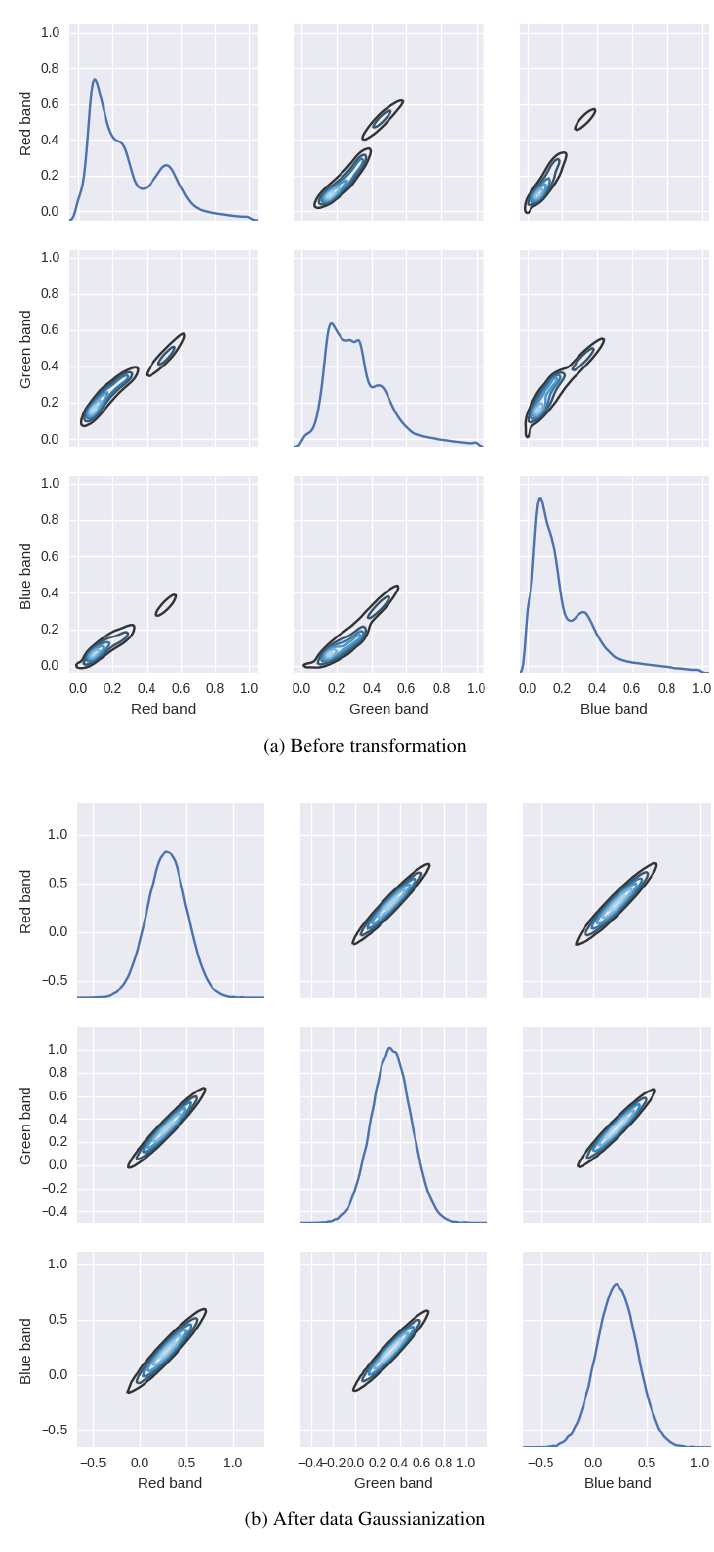
Figure 6: Visualization of the pairwise relationships between two